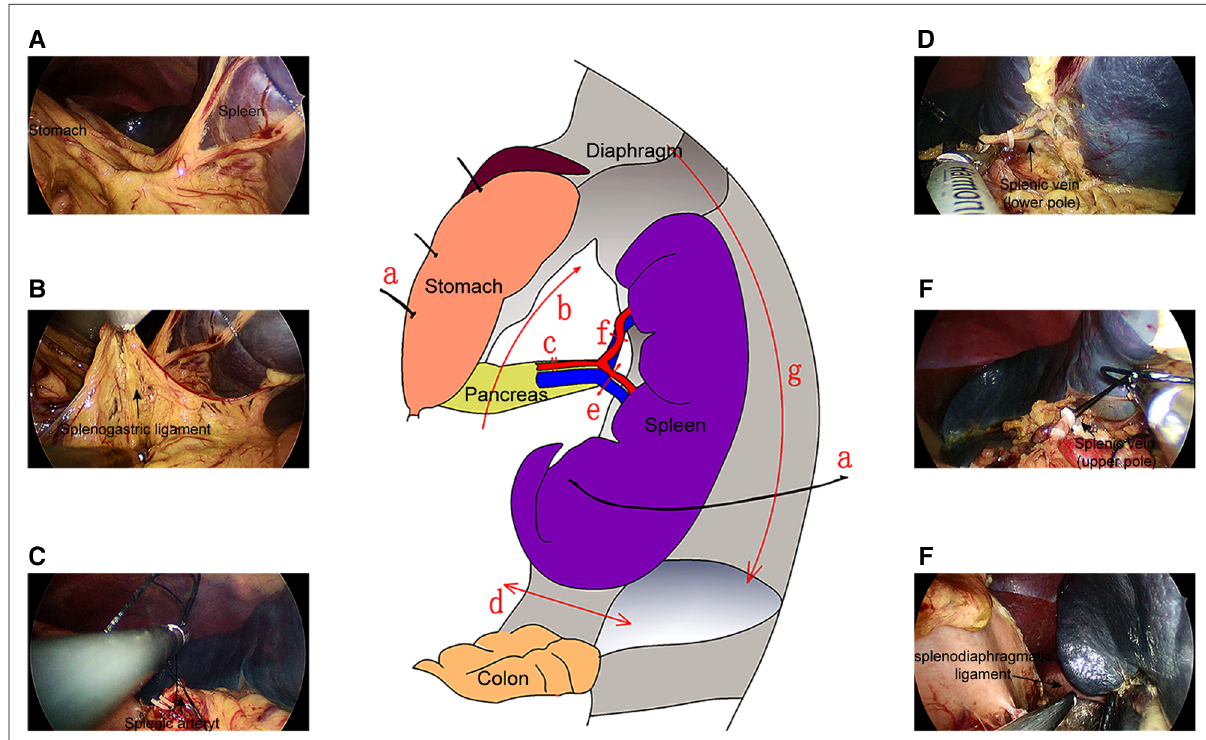
FIGURE 2 Operation fl ow of the SILS. ( A ) The traction sutures were used to pull the spleen and stomach, such that the splenogastric ligaments were in tension. ( B ) The splenogastric ligament was cut to expose the pancreatic tail and splenic hilum. ( C ) The splenic artery was exposed, divided, and ligated. The lower pole ( D ) and upper pole vein ( E ) of the spleen was exposed, ligated, and cut off. ( F ) The splenodiaphragmatic ligament and splenorenal ligament were